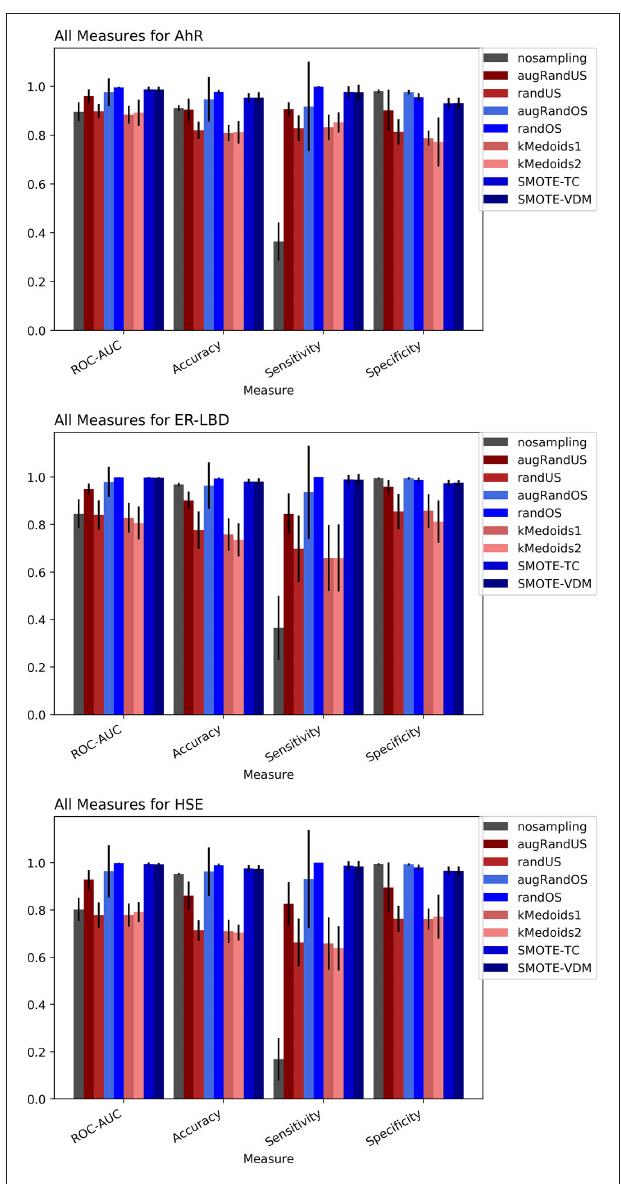
FIGURE 2 | Performance measures for cross-validation -AhR (A) , ER-LBD (B) , and HSE (C) models based on Random Forest Classifier and MACCS fingerprints.